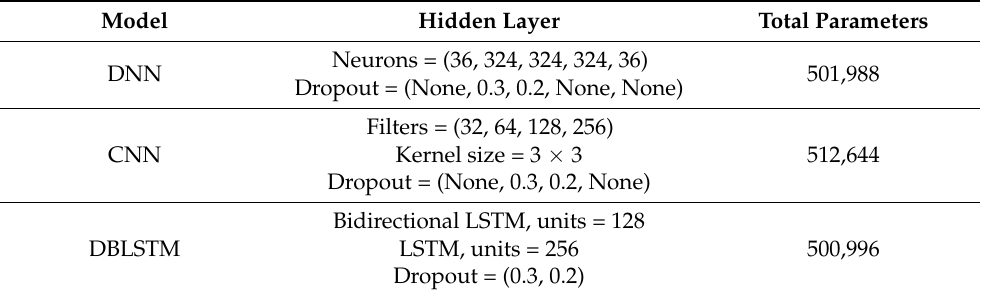
Table 1. Details for model